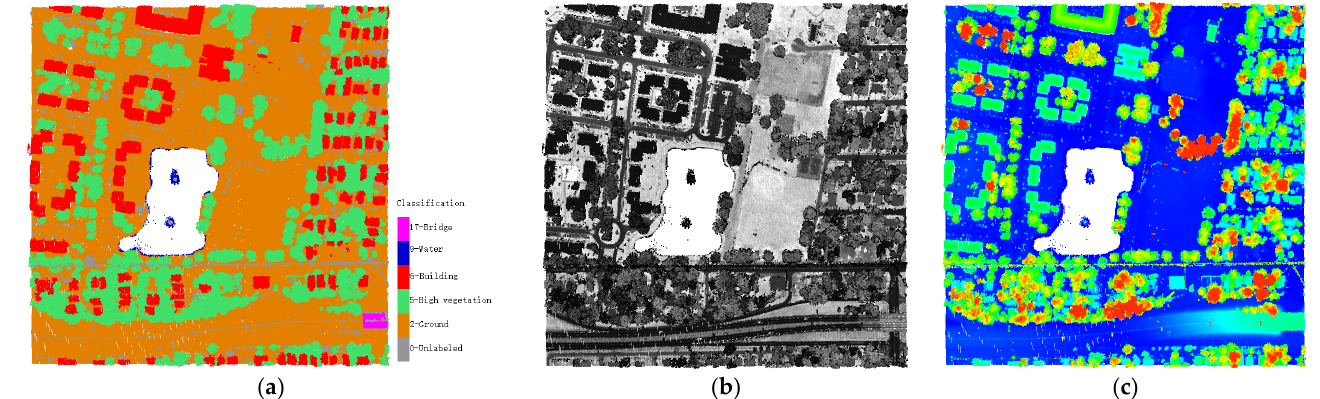
Figure 6. DFC 3D dataset. One tile of the training set ( a ) colored by classes; ( b ) colored by intensity; ( c ) colored by height.